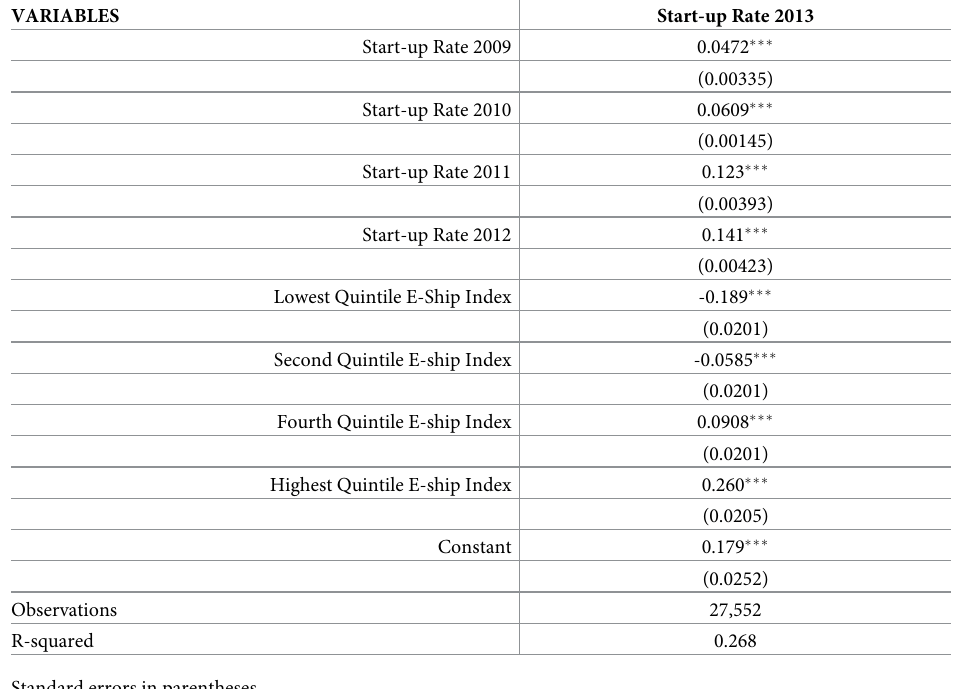
Table 7. Regression of 2013 start-up rate on lagged start-up rates and E-ship index quintiles.